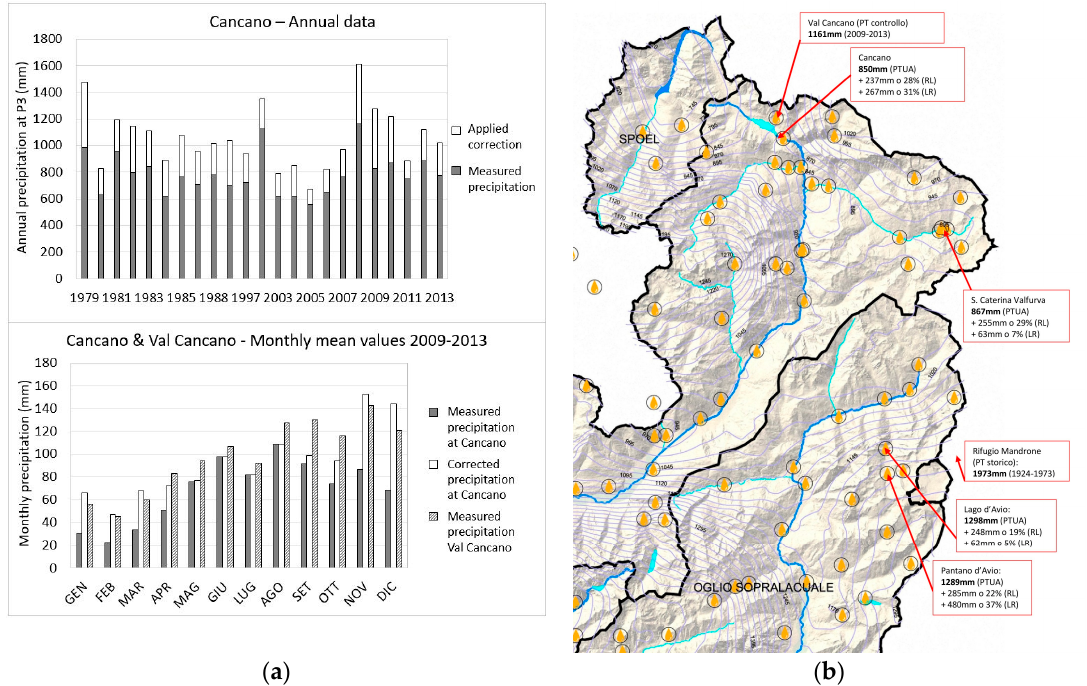
Figure 7. ( a ) The effects of the application of the correction model to the precipitation data gathered by mechanical SIAP heated tipping-bucket recording gauges in Cancano. In the upper part, the annual values and, beneath, the monthly mean values for the 2009–2013 period also compared with the precipitation measured by the close weighing storage gauge with wind-shields at the Val Cancano monitoring site. ( b ) Probability part of the official Lombardy mean annual precipitation map, made in 2003 for the General Water Management and Protection Plan (PTUA). For the highlighted stations a more representative value using the correction model was estimated: the panels show a comparison between the official values with no correction (PTUA), the correction suggested by Regione Lombardia (RL), from a mean estimated SWE, and the correction suggested in this paper using the Lendvai-Ranzi model (LR). For a better comparison, the mean annual precipitation are also measured at two weighing storage gauges with wind-shields (PT) are